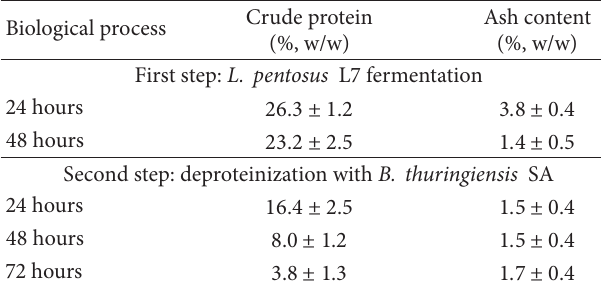
Table 3: Residual crude protein and ash content in decalcified shrimp shells and raw chitin flakes during purification by a two-step biological